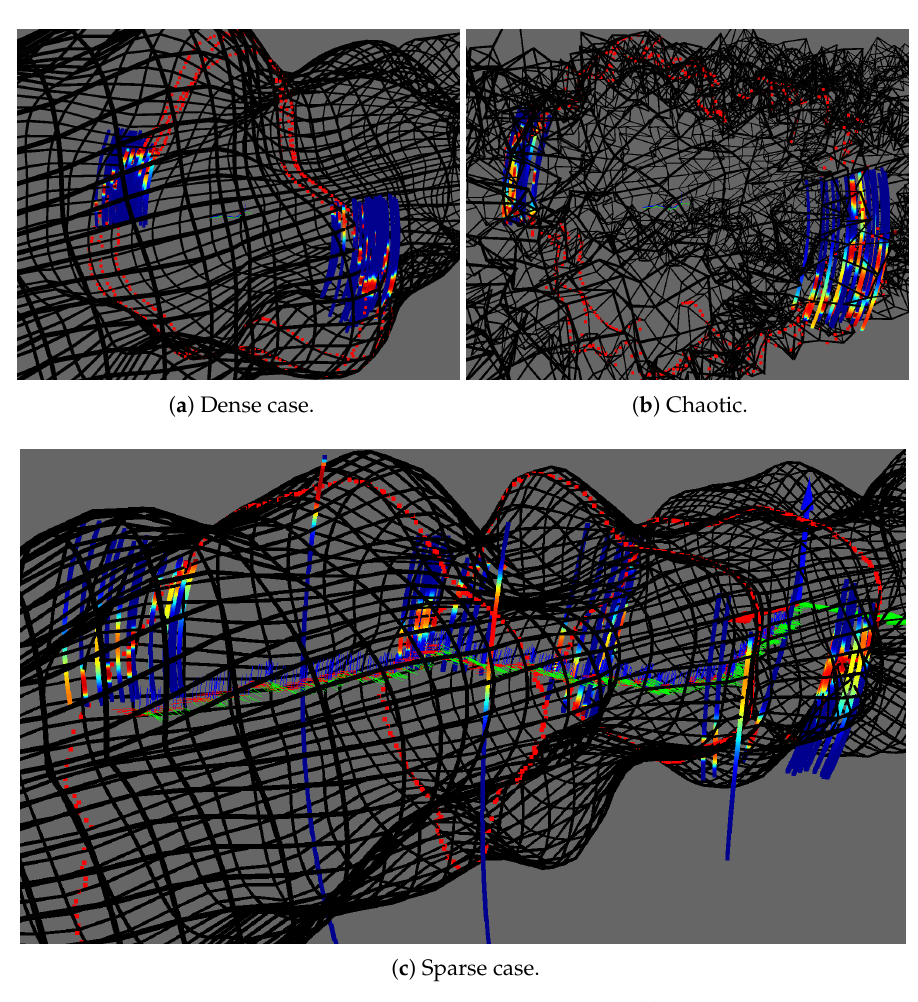
. For better visibility, uniform 5 2